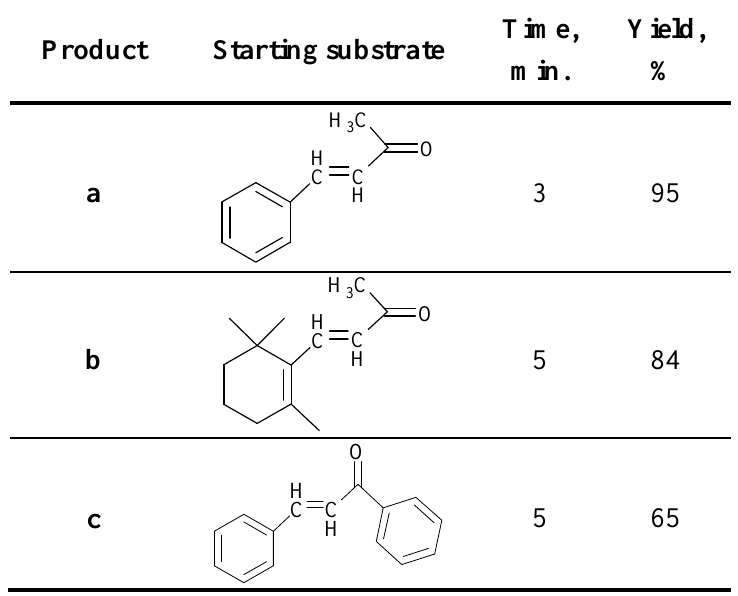
Table 4. MW-assisted “one pot synthesis” (MW2) of compounds a-c from carbonyl precursors.